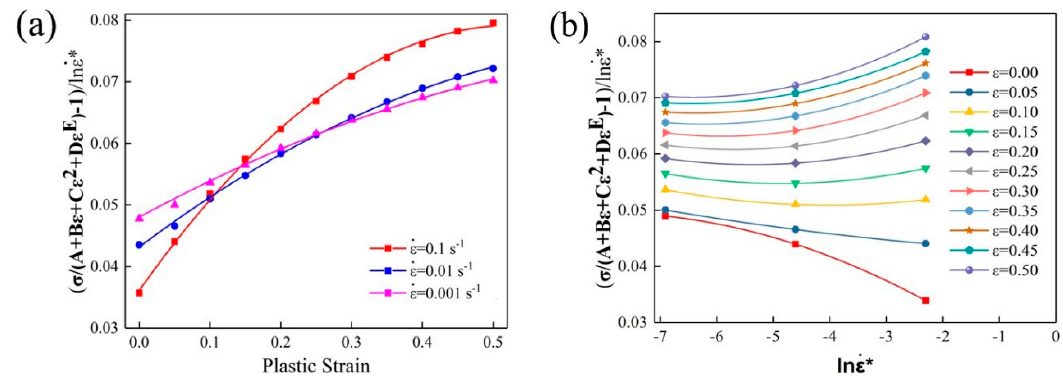
Figure 4. Relationship between σ /